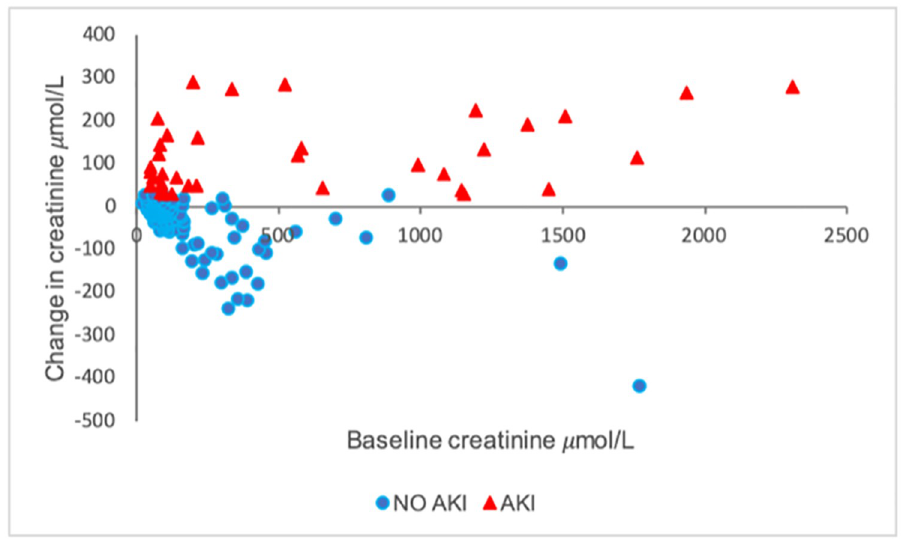
Fig 1. Change in serum creatinine in μ mol/L by AKI group (AKI, or no AKI) observed at 48 hours, compared to baseline, for each patient.